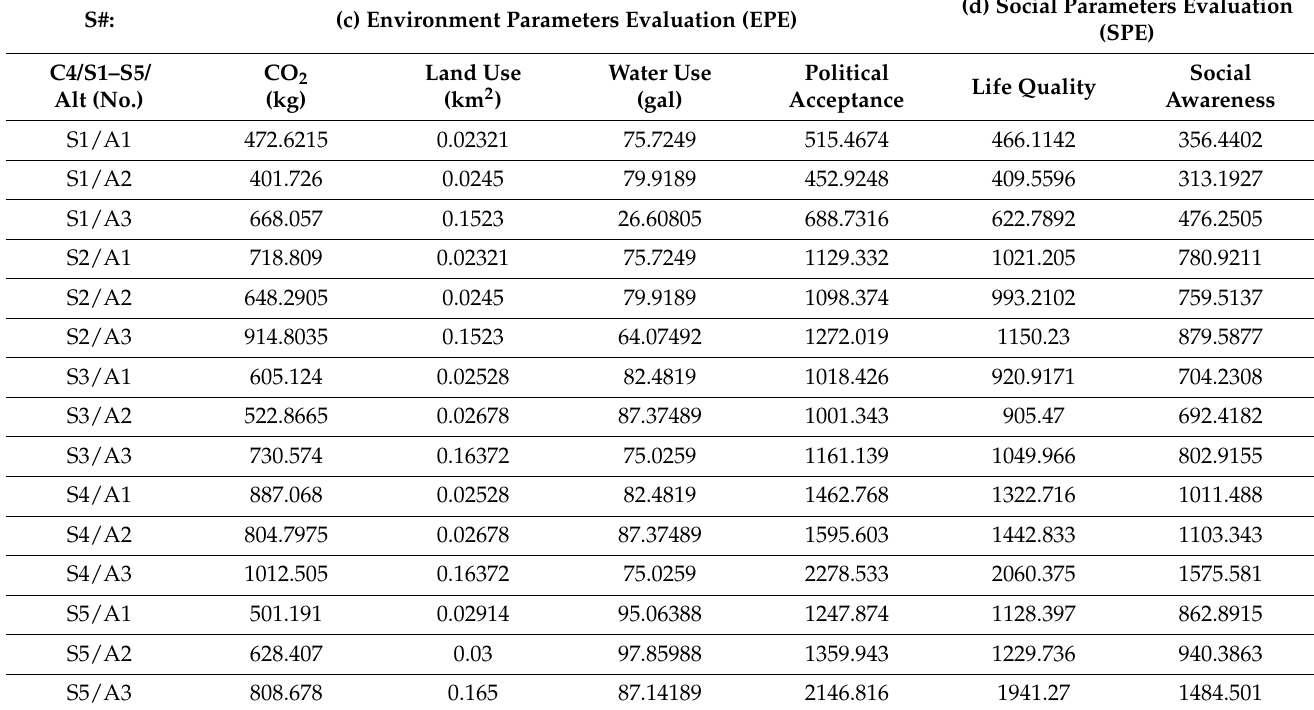
Table 19. EPE/SPE evaluations in C4/S1–S5 for the 65-bus MCMG (NUST_MG) for